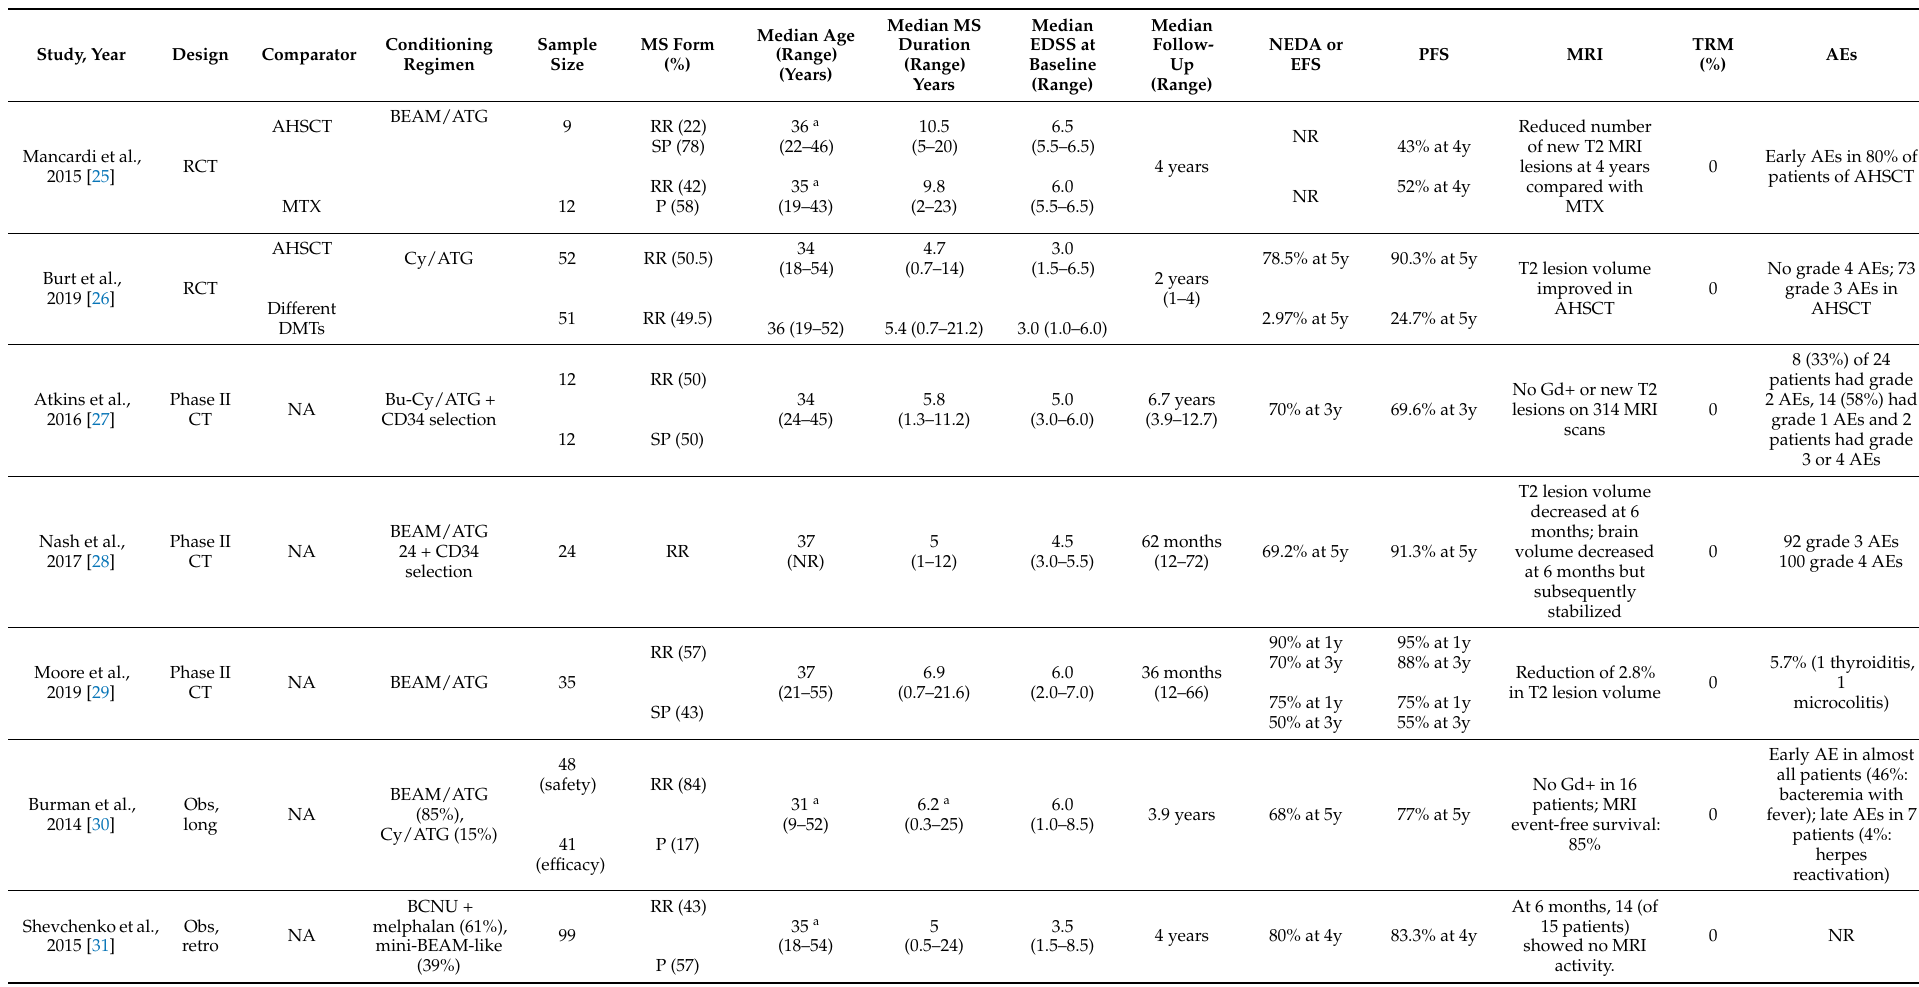
Table 2. Relevant studies about the use of AHSCT in Multiple